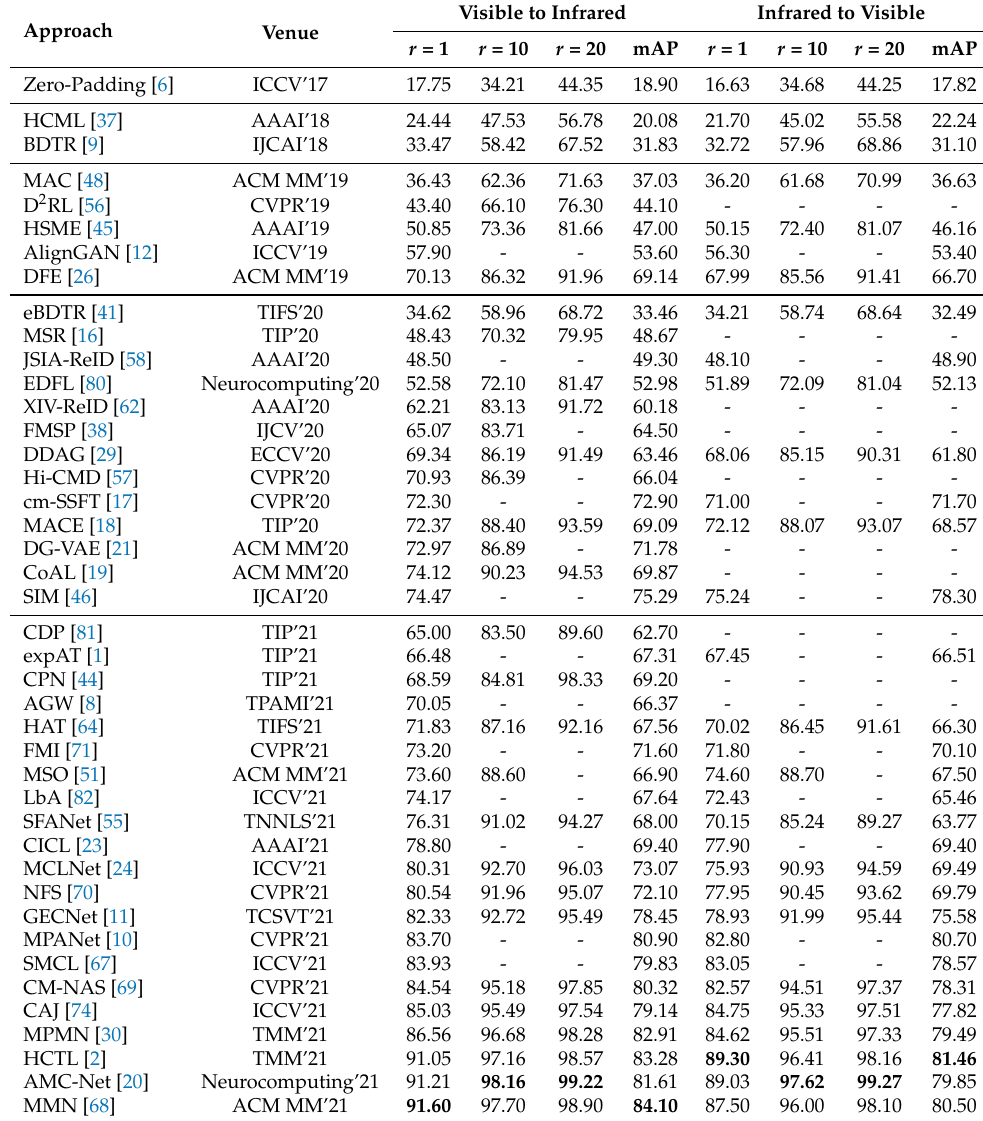
Table 2. Rank- r accuracy (%) and mAP (%) performance of state-of-the-art methods on RegDB. Bold numbers are the best